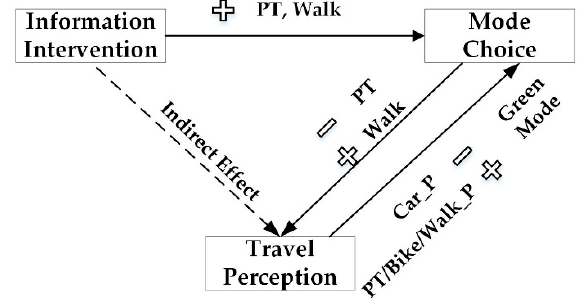
Figure 5. Relationship among information intervention, mode choice, and travel perception. (Note ：